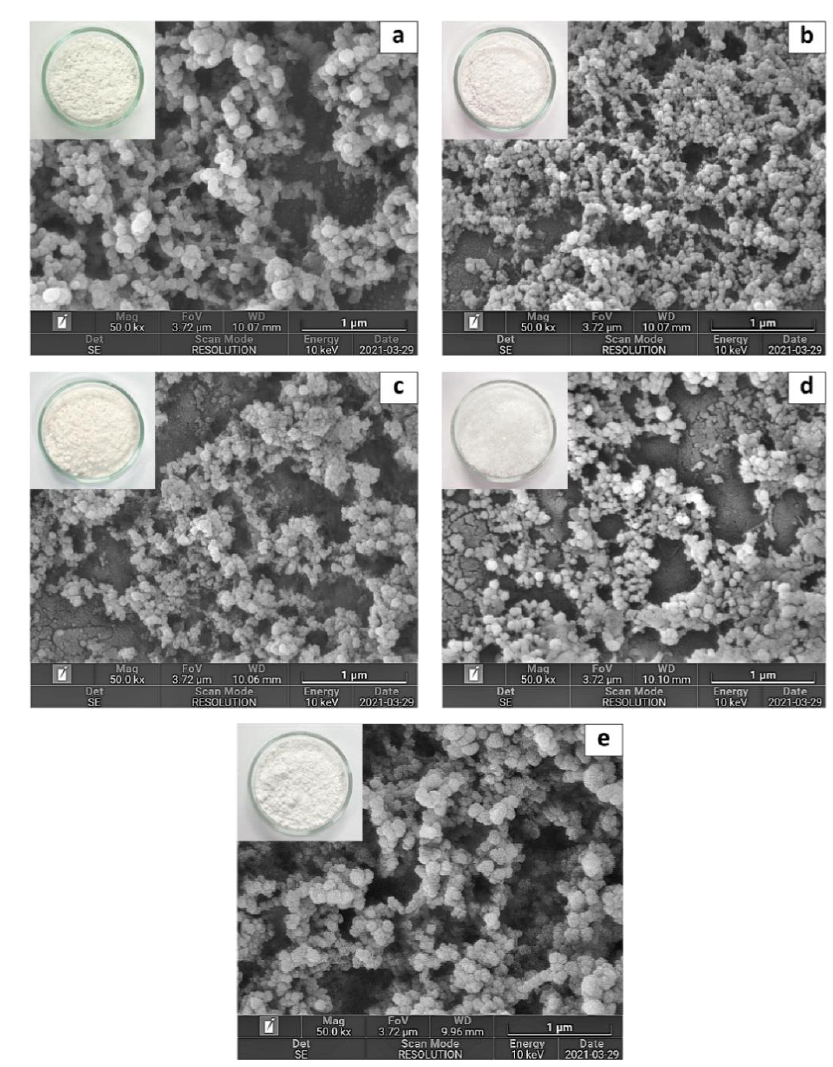
Figure 1. Scanning electron micrograph of cellulose nanosphere isolated from different sources compared with commercial cellulose: ( a ) rice straw, ( b ) corncob, ( c ) pineapple leaf, ( d ) pineapple peel, and ( e ) commercial cellulose ( magnification 50 k× ).